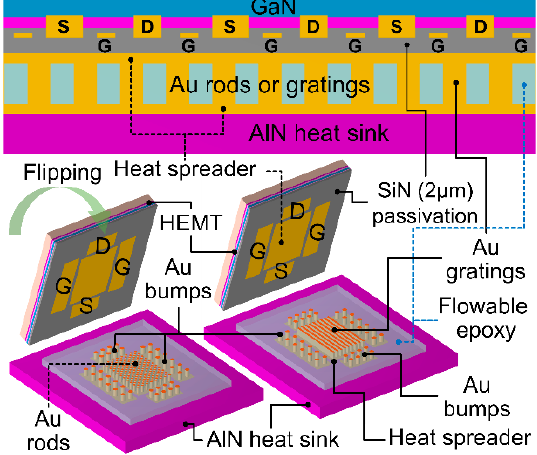
Figure 2. Cross-sectional view and three-dimensional schematics of the proposed flip-chip bonding designs for high power GaN HEMTs.